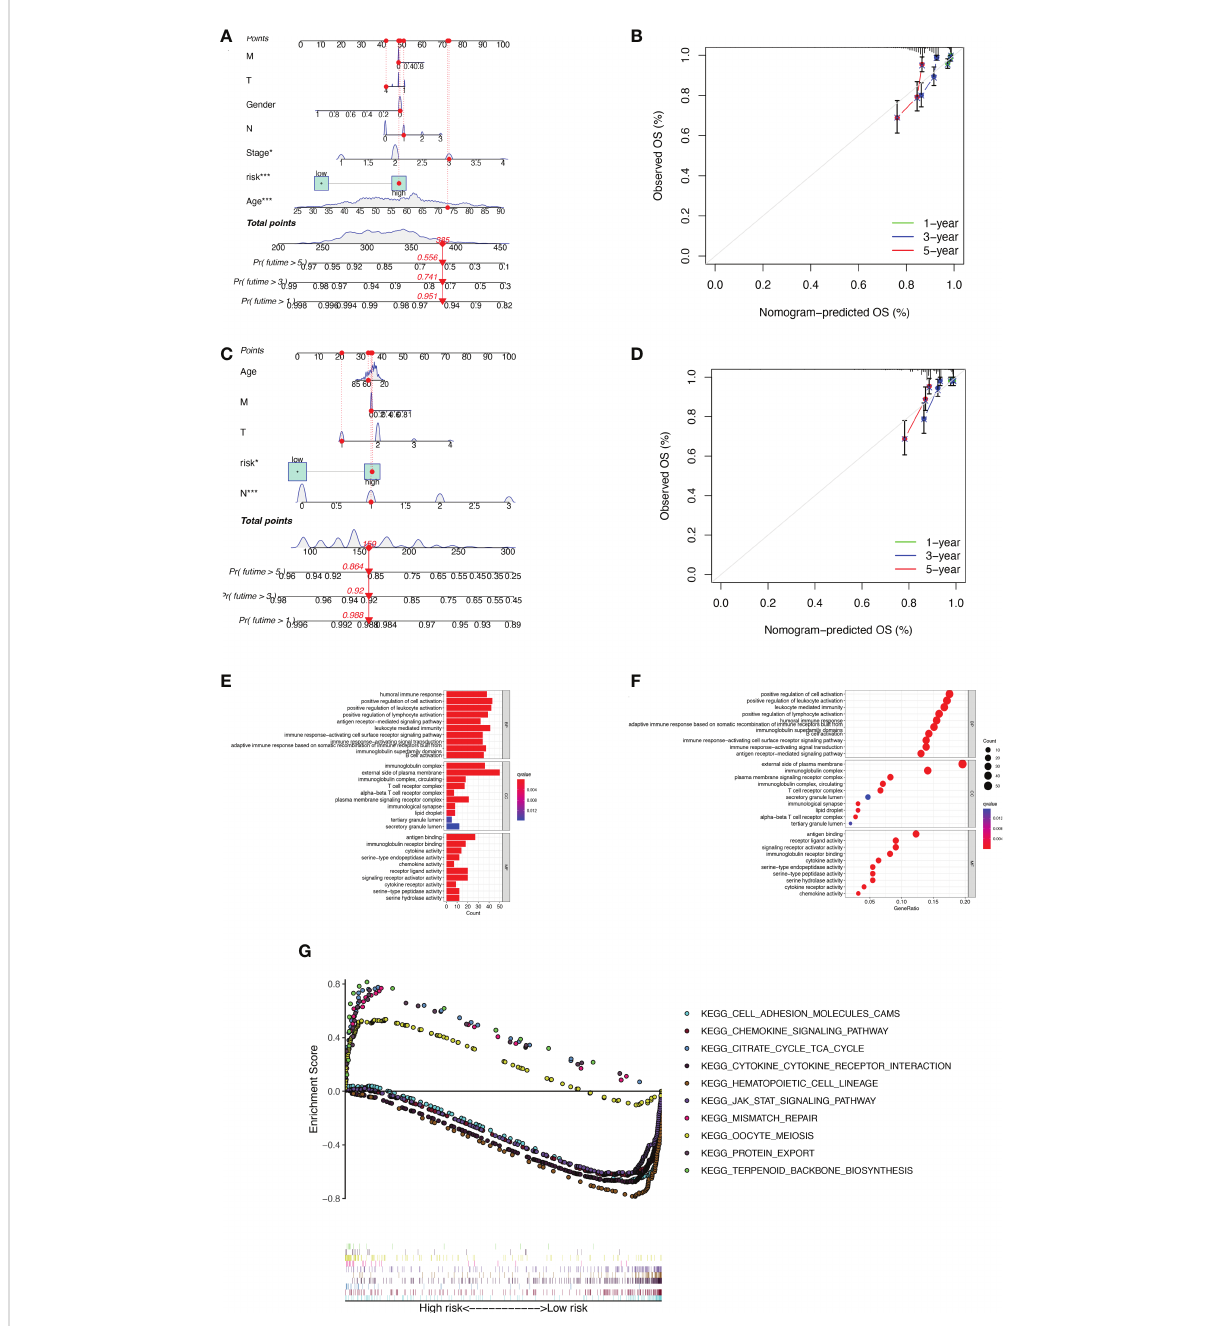
FIGURE 4 Construction of column line graphs and enrichment analysis of BMRGs. (A – D) Combined risk score and clinical parameters to predict the column line graphs of 1, 3, and 5-year OS of BC patients in the training set (A) and validation set (C) ; calibration curves of 1, 3, and 5-year OS in the training set (B) and validation set (D) . (E – F) GO functional enrichment analysis. (G) GSEA multi-pathway enrichment